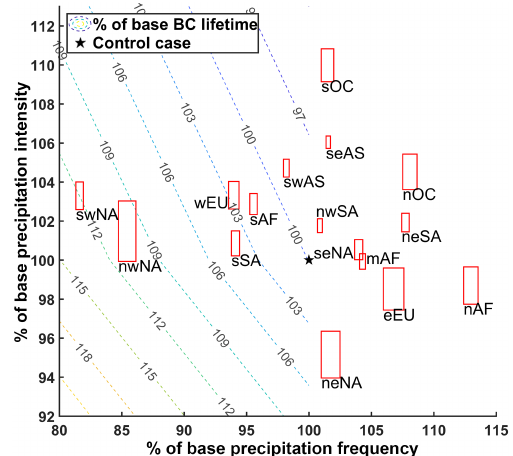
Figure 4. The potential change of atmospheric BC aerosol lifetime driven by the changes between the two periods (2008–2014 and 2001–2007) in precipitation characteristics based on the TRMM meteorological dataset. The dashed contours are the same as in Fig. 2, which indicate the atmospheric lifetimes of the black carbon aerosols from the interpolation of 20 cases and show the potential changes of BC lifetimes from the base BC lifetime (in the control run) driven by the changes of precipitation intensity and frequency. Red blocks show the changes of precipitation intensities and fre- quencies, with the size of the block showing the standard error of the percentage